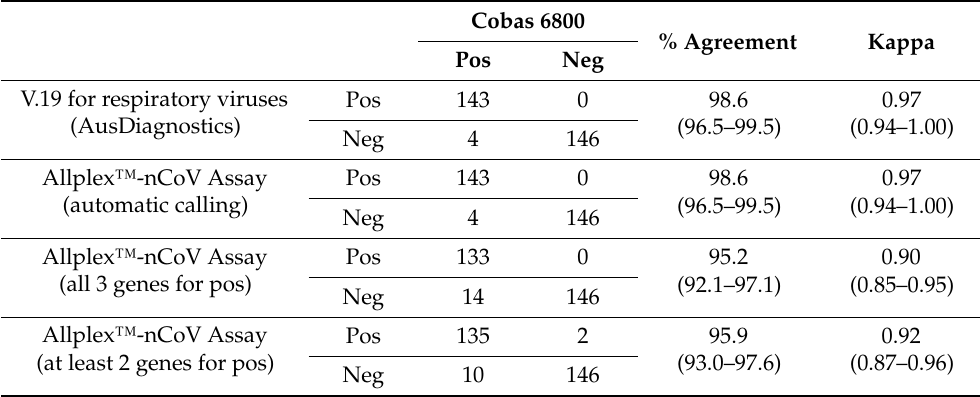
Table 2. Comparison between cobas 6800 (reference method), the Respiratory Viruses 16-Well Assay V.19, and the Allplex™-nCoV